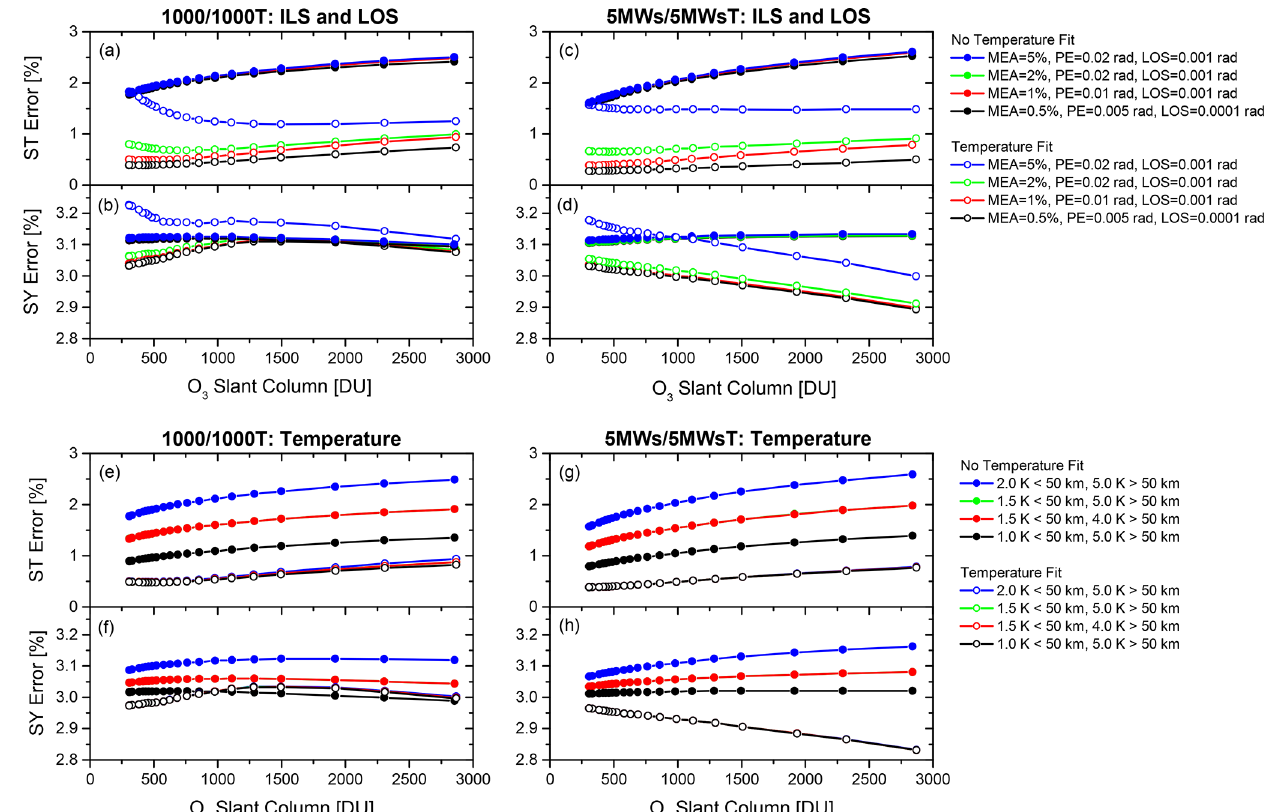
Figure B2. Estimated statistical (ST) and systematic (SY) TPE (%) for O 3 TCs retrieved from the setups 1000/1000T (a, b, e, f) and 5MWs/5MWsT (c, d, g, h) for different error configurations of the ILS function, LOS, and atmospheric temperature profile as a function of O 3 slant column (DU) for the measurements of Fig.